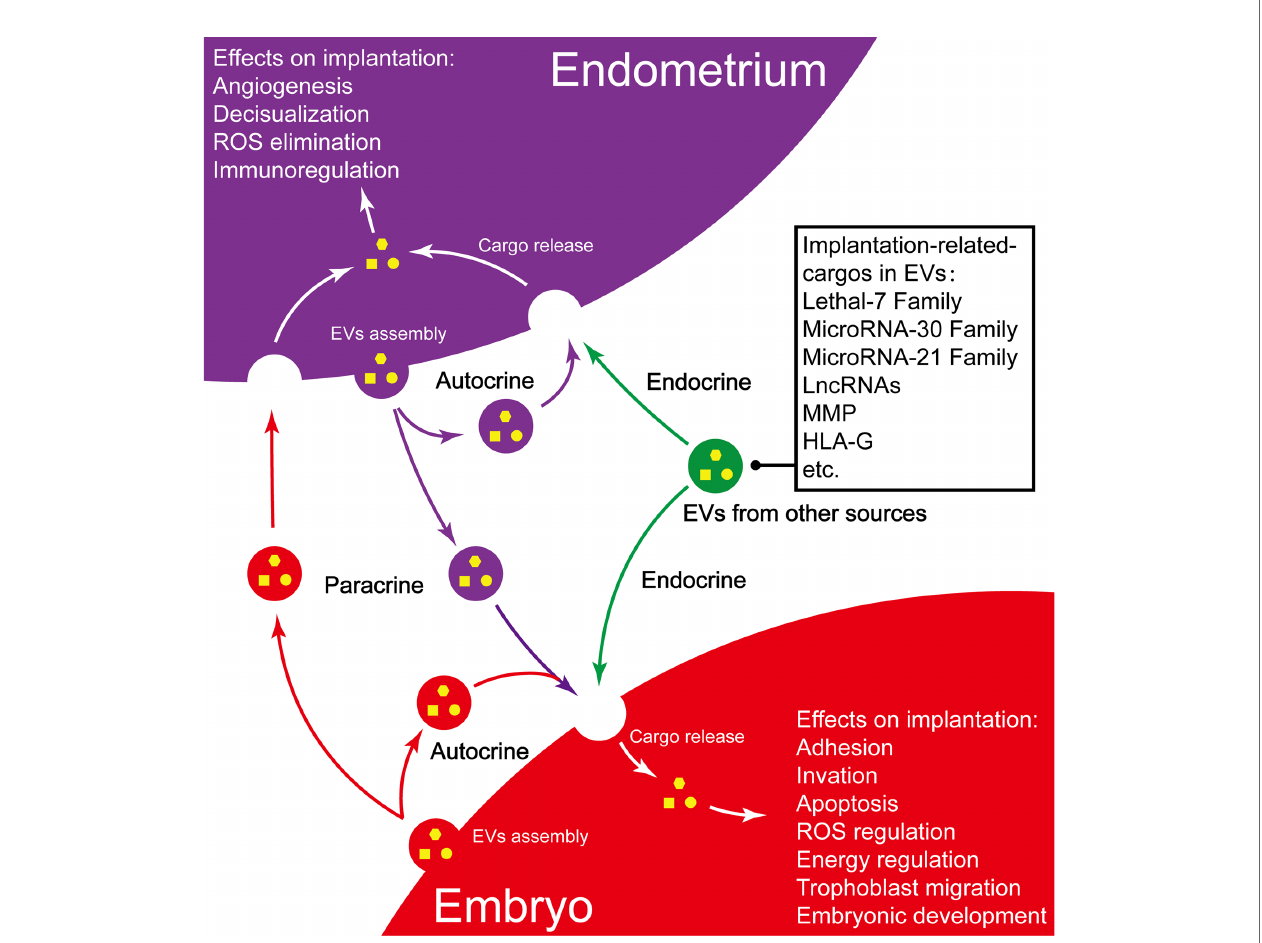
FIGURE 2 | Summary of EVs and their implication in embryo implantation. Purple vesicles, endometrium-derived EV; Red vesicles, embryo-derived EVs; Green vesicles, EVs from other